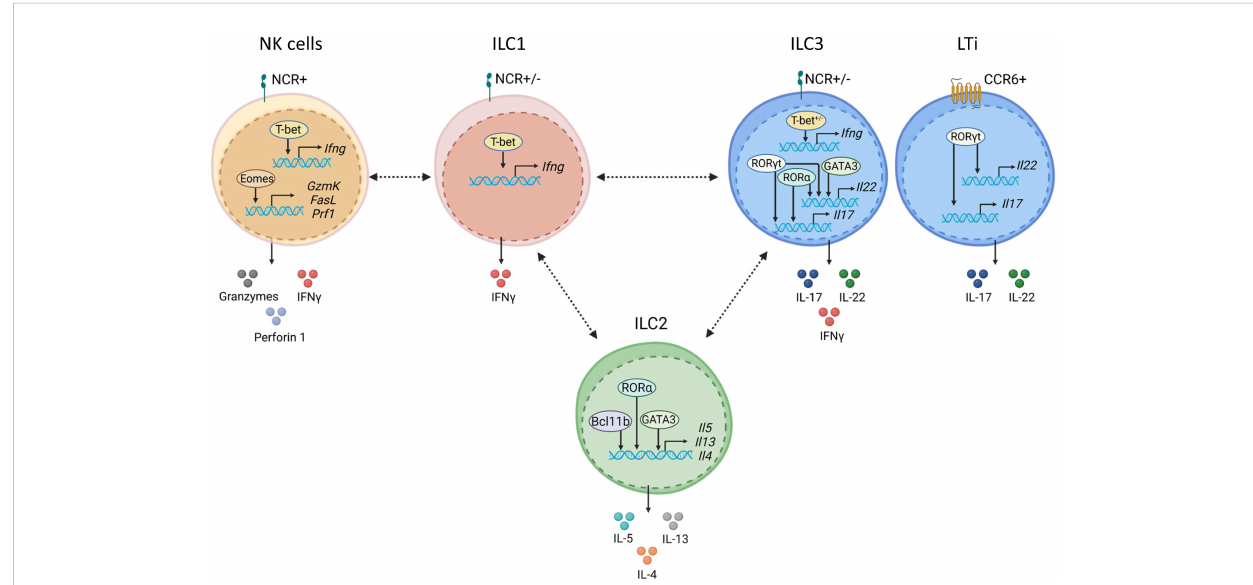
FIGURE 1 ILC subsets are de fi ned by core transcription factors. NK cells express natural cytotoxicity receptors (NCRs) and require Eomes and T-bet for their development. Eomes and T-bet maintain NK cell effector functions by inducing granzymes, perforin 1, and IFN g . ILC1 development and maintenance depends on T-bet, which is required for IFN g production. ILC2s require GATA3 for their development and maintenance. Bcl11b promotes ILC2 development by controlling ILC2 lineage associated genes and by restraining ILC3 development. ROR a , Bcl11b and GATA3 control production of type 2 effector cytokines, IL-5, IL-13 and IL-4 in ILC2. ILC3s and LTi cells express ROR g t, which is required for their development and maintenance. ROR g t with ROR a induce type 3 effector cytokines, IL-17 and IL-22. ILC3s are divided on NCR + and NCR - subsets. Development of NCR + ILC3s depends on GATA3 and T-bet. GATA3 together with ROR g t regulate IL-22. LTi cells express CCR6. Plasticity between ILC subsets is shown by dashed black